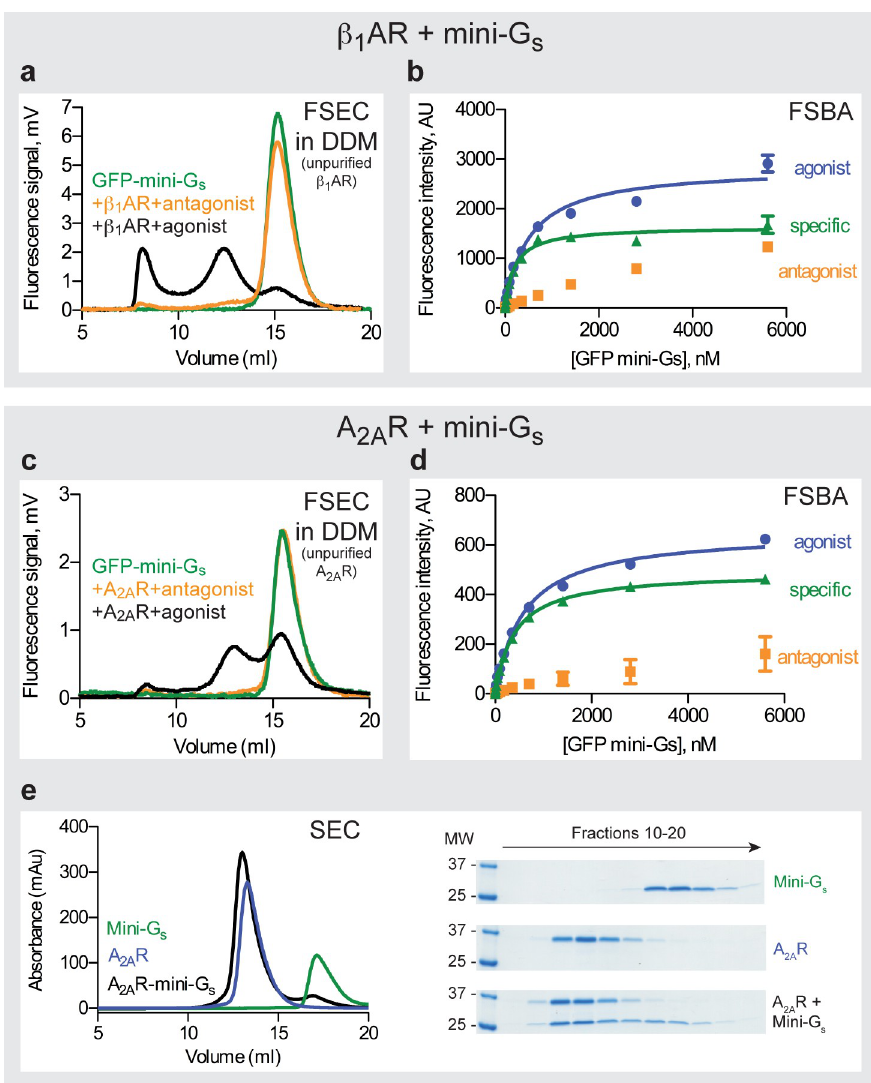
Fig 3. The β 1 AR − mini-G s and A 2A R − mini-G s complexes. ( a )FSECtracesof GFP-mini-G s with β 1 AR (retention volumesaregiveninparentheses): green,GFP-mini-G s (15.1ml); orange,GFP-mini-G s with β 1 AR boundto the inverseagonistICI118551 (15.1ml); black,GFP-mini-G s with β 1 AR boundto the agonistisoprenaline(8 ml, 12.1 ml and15.1ml). Representativechromatogramsfromat leasttwo independentexperimentsareshown.( b ) Measurementof GFP-mini-G s affinityto DDM-solubilized β 1 AR usinga fluorescent saturationbindingassay (FSBA);bluecircles, β 1 AR boundto the agonistisoprenaline(totalbinding);orangesquares, β 1 AR boundto the inverseagonistICI118551 (non-specific binding);greentriangles,specificbinding,withan apparent K D of 200 ± 1 nM (mean ± SEM, n = 2).Curvesshownarefroma representative experiment. ( c )FSECtracesof GFP-mini-G s withDDM-solubilisedA 2A R (retentionvolumesaregiveninparentheses): green,GFP-mini-G s (15.1ml); orange, GFP-mini-G s withA 2A R boundto theinverseagonistZM241385(15.1ml); black,GFP-mini-G s withA 2A Rboundto theagonistNECA(12.5ml and15.1ml). Representativechromatograms fromat leasttwo independent experi- mentsareshown.( d )Measurementof mini-G s affinityto DDM-solubilizedA 2A RusingFSBA:bluecircles,A 2A R boundto theagonistNECA(totalbinding);orangesquares,A 2A Rboundto the inverseagonistZM241385 (non- specificbinding);greentriangles,specificbinding,withan apparent K D of 430 ± 24nM (mean ± SEM, n = 2).( e ) Analytical sizeexclusionchromatography(SEC)of mini-G s boundto purifiedA 2A R(retentionvolumesaregivenin parentheses): black,A 2A R–mini-G s complex,153kDa(13ml); blue,A 2A R,133kDa(13.3ml); green,mini-G s , 22 kDa(17.2ml). Threepanelsto therightof theSECtracesarecoomassieblue-stained SDS-PAGE gelsof fract- ionsfrom3 separate SECexperiments:top panel,mini-G s ; middlepanel,A 2A R;bottompanel,mini-G s mixedwith NECA-boundA 2A